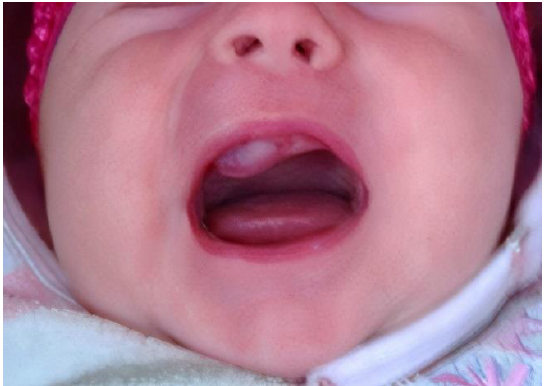
Figure 1. Patient 1: an intraoral tumor originating from the right side of the maxilla at first admission to the clinic.